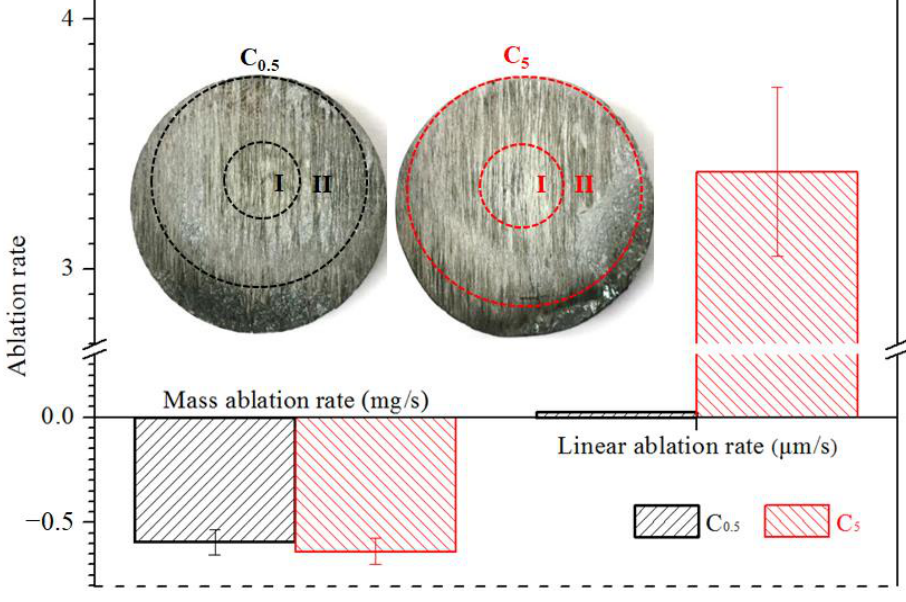
Figure 3. Ablation rates and macro-morphologies of the ablated C/C-SiC-ZrC samples.